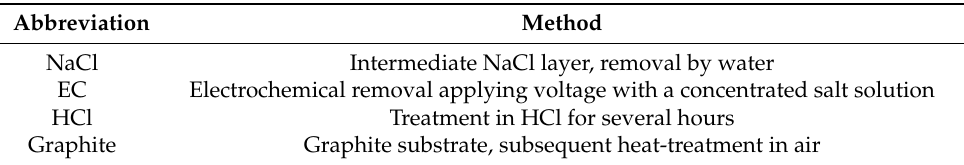
Table 1. Summary of the used substrate removal methods.